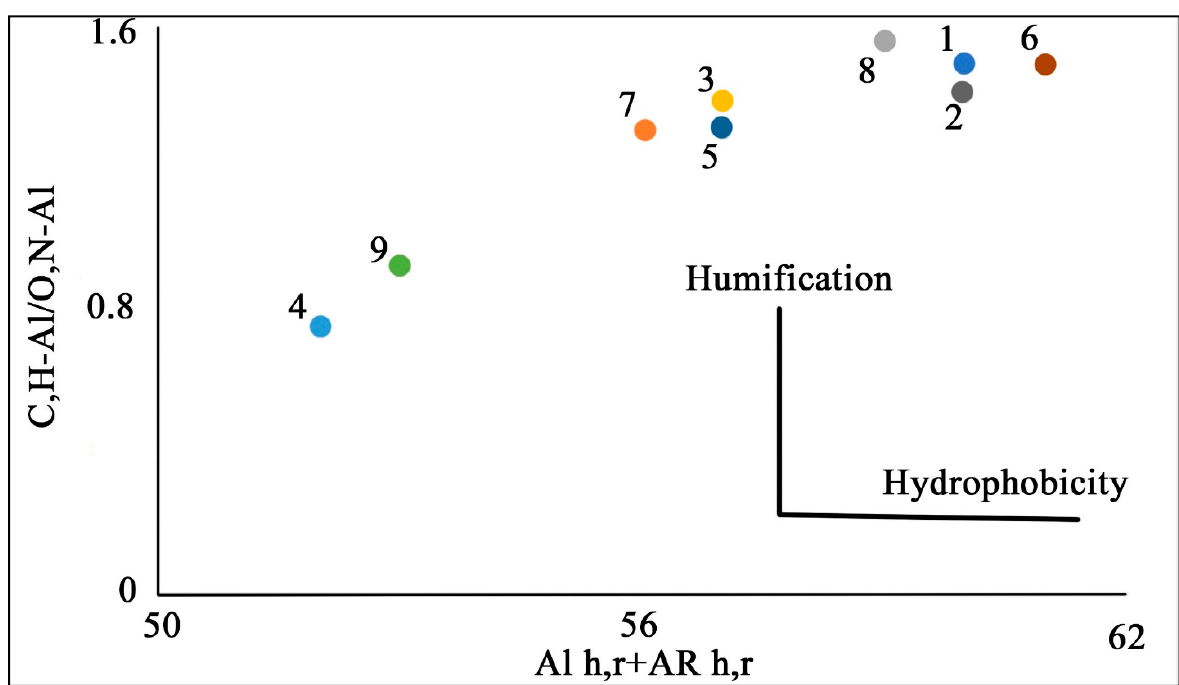
Figure 5. The diagram of integrated indicators of the molecular composition of HAs. Soil IDs correspond to Table 1.